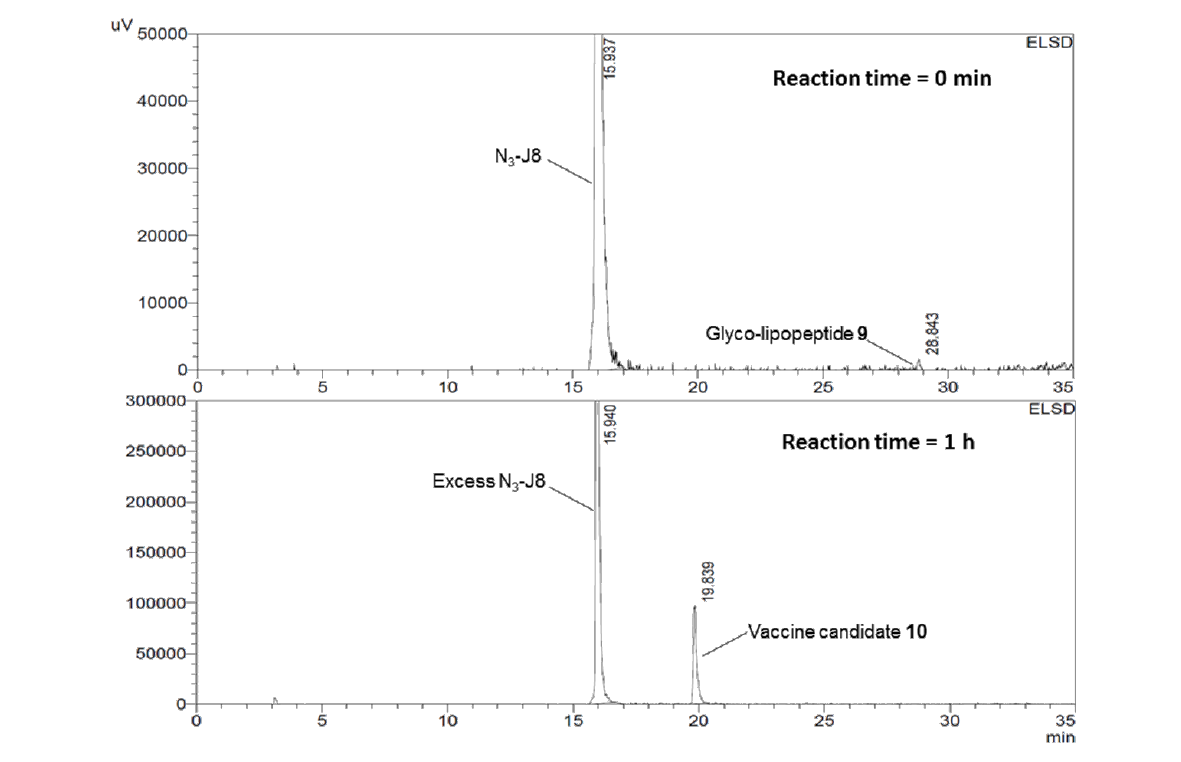
Figure 1: Analytical HPLCs of copper-catalyzed alkyne–azide cycloaddition reaction at the start (top) and after 1 h (bottom) (gradient; 0–100% solvent B over 30 min).